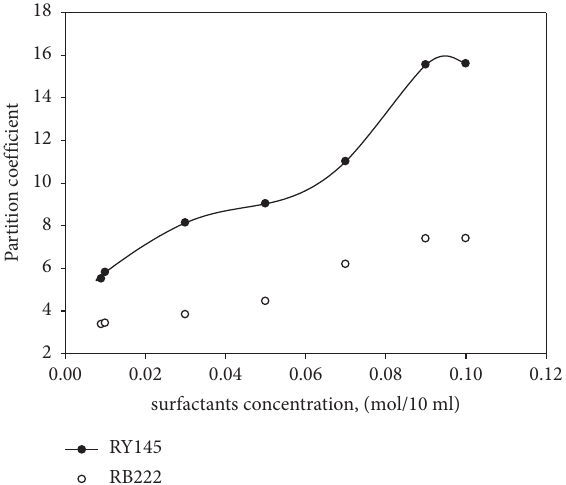
Figure 14: Partition coefficient ( K ) for RY145 and RB222 by varying the concentration of the surfactant.